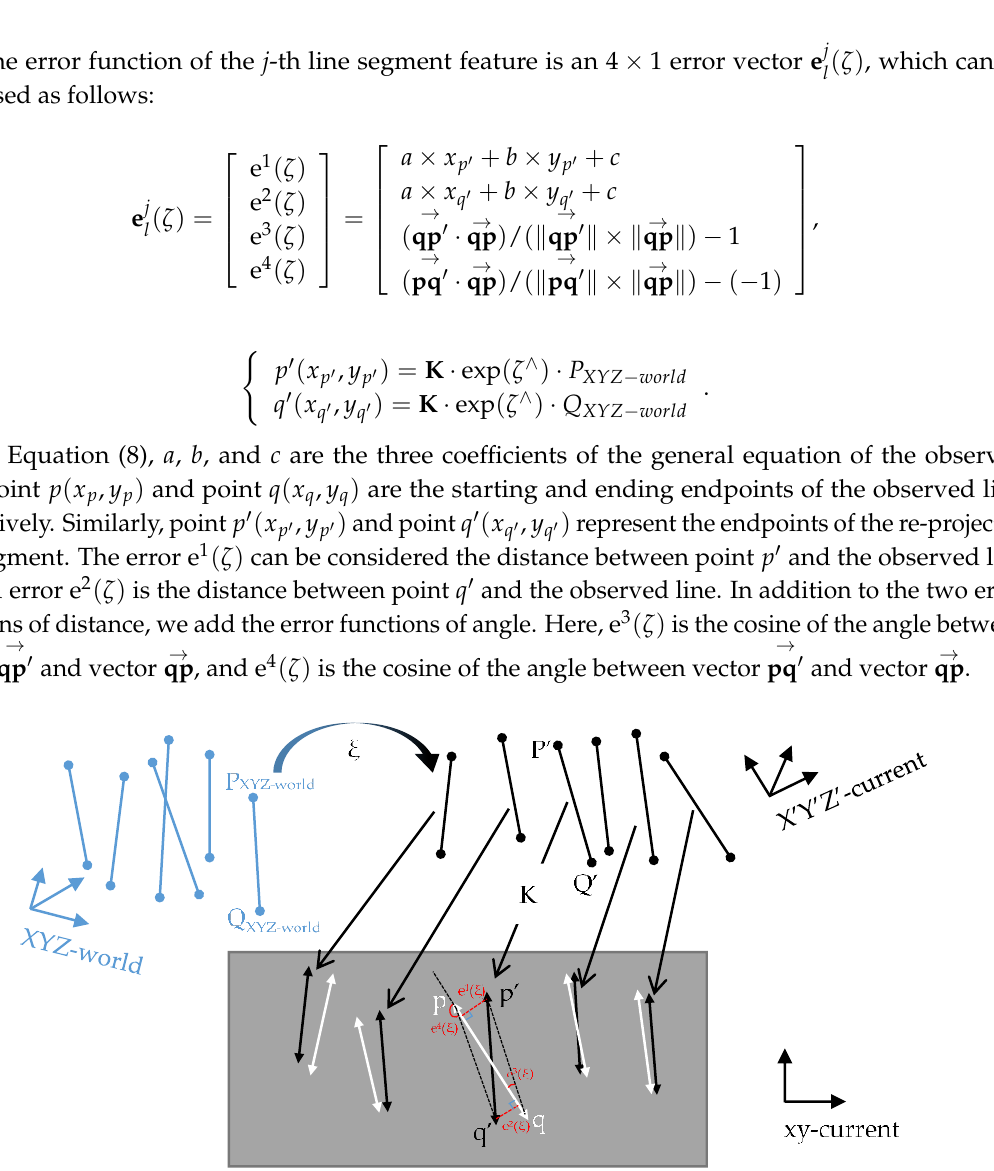
Figure 5. Process of building an error model of line segment features. The blue lines and black lines represent the world 3D map line segments and current 3D map line segments, respectively. The black and white lines with triangular endpoints represent the re-projected and observed line segments, respectively.